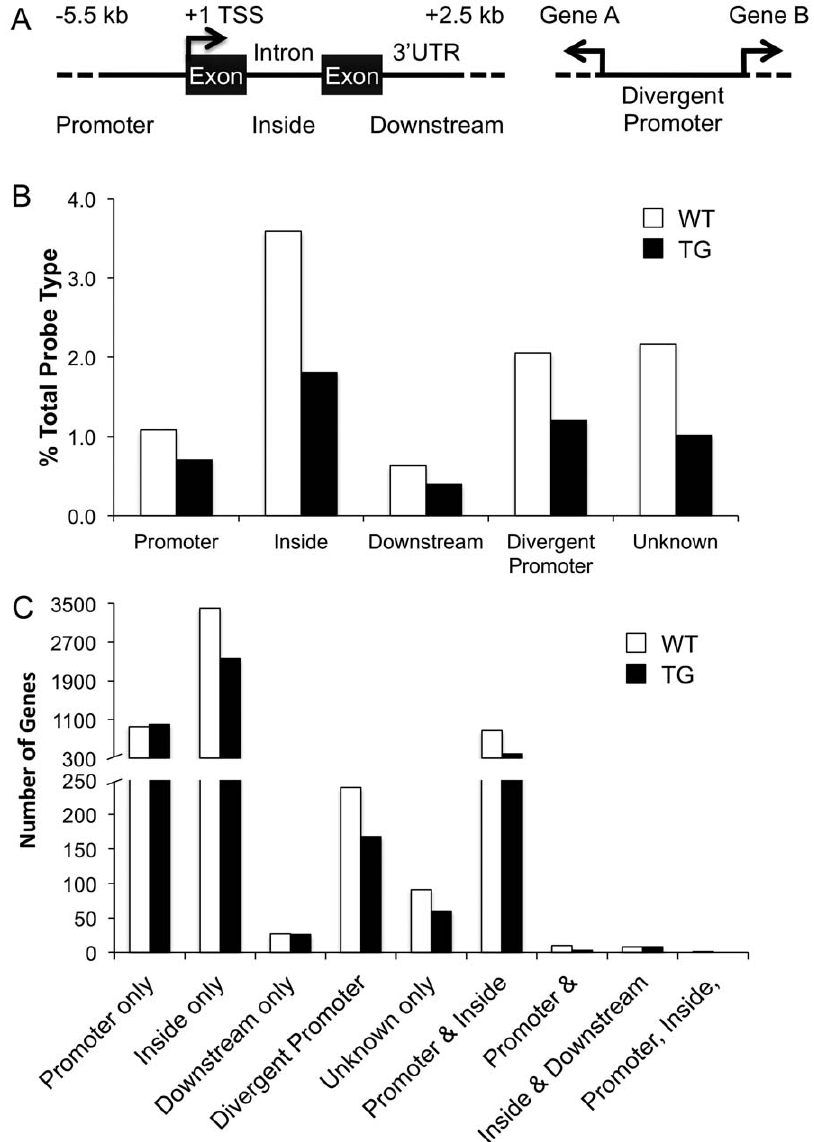
Figure 4. AcH3 localization is found downstream of transcriptional start sites within the gene. (A) Schematic indicating the location of probes as defined by Agilent annotation. Promoter=upstream of transcriptional start site; Inside=within coding region of gene; Down- stream=downstream of coding region; Divergent promoter=located within the upstream region of two genes transcribed in opposite directions; Unknown=unannotated. (B) Locations of probes within the gene expressed as percent bound of total probe type within the microarray. (C) Numbers of genes bound as expressed by AcH3-bound locationsWhite bars, WT; black bars, TG.